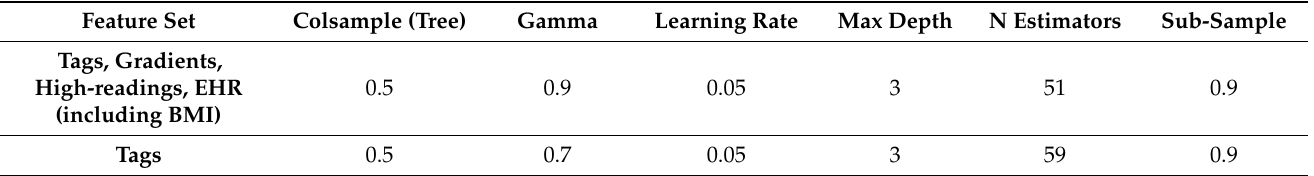
Table A6. Hyperparameter values used in model development (XGBoost) for additional experi- ments: (1) Including BMI as a feature, (2) Using a dataset filtered for blood glucose range [1, 30].